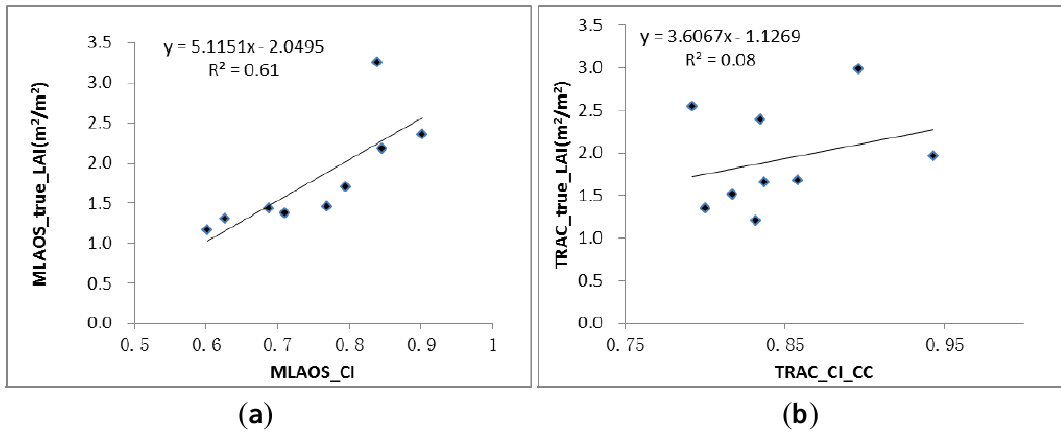
Figure 9. Scatter plot on LAI and CI from ( a ) MLAOS and ( b ) TRAC